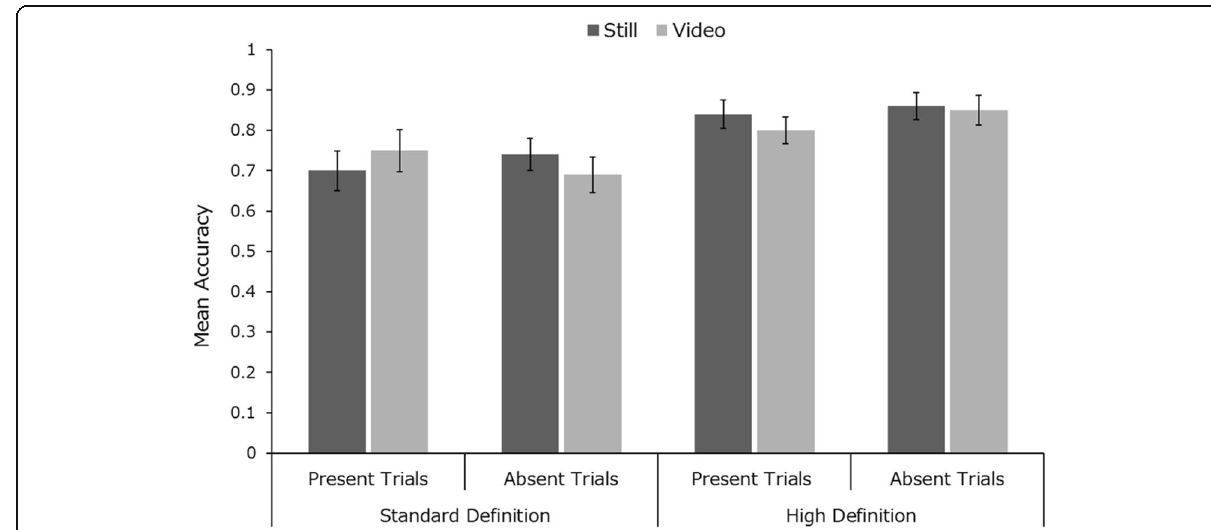
Fig. 6 Mean identification accuracy across search stimulus, video quality and trial type in study 3. Error bars represent within-subjects standard error (Cousineau,